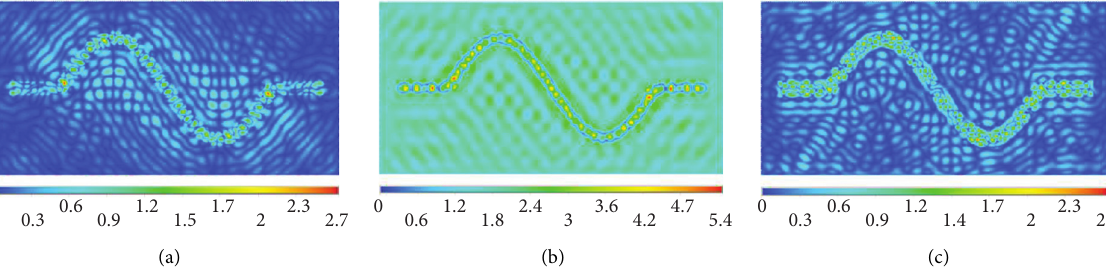
Figure 26: SH wave incident ( H � 100m, f � 5.0Hz, C